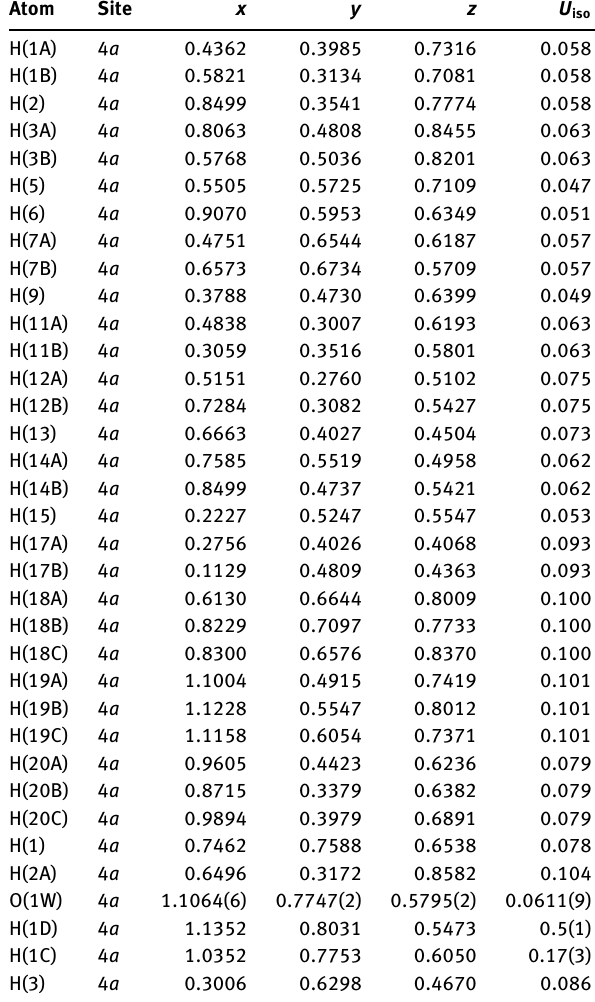
Table 2: Fractional atomic coordinates and isotropic or equivalent isotropic displacement parameters (Å 2